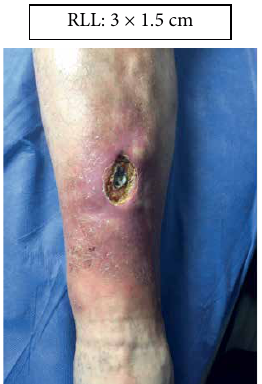
Figure 17: Start. Lower right limb.